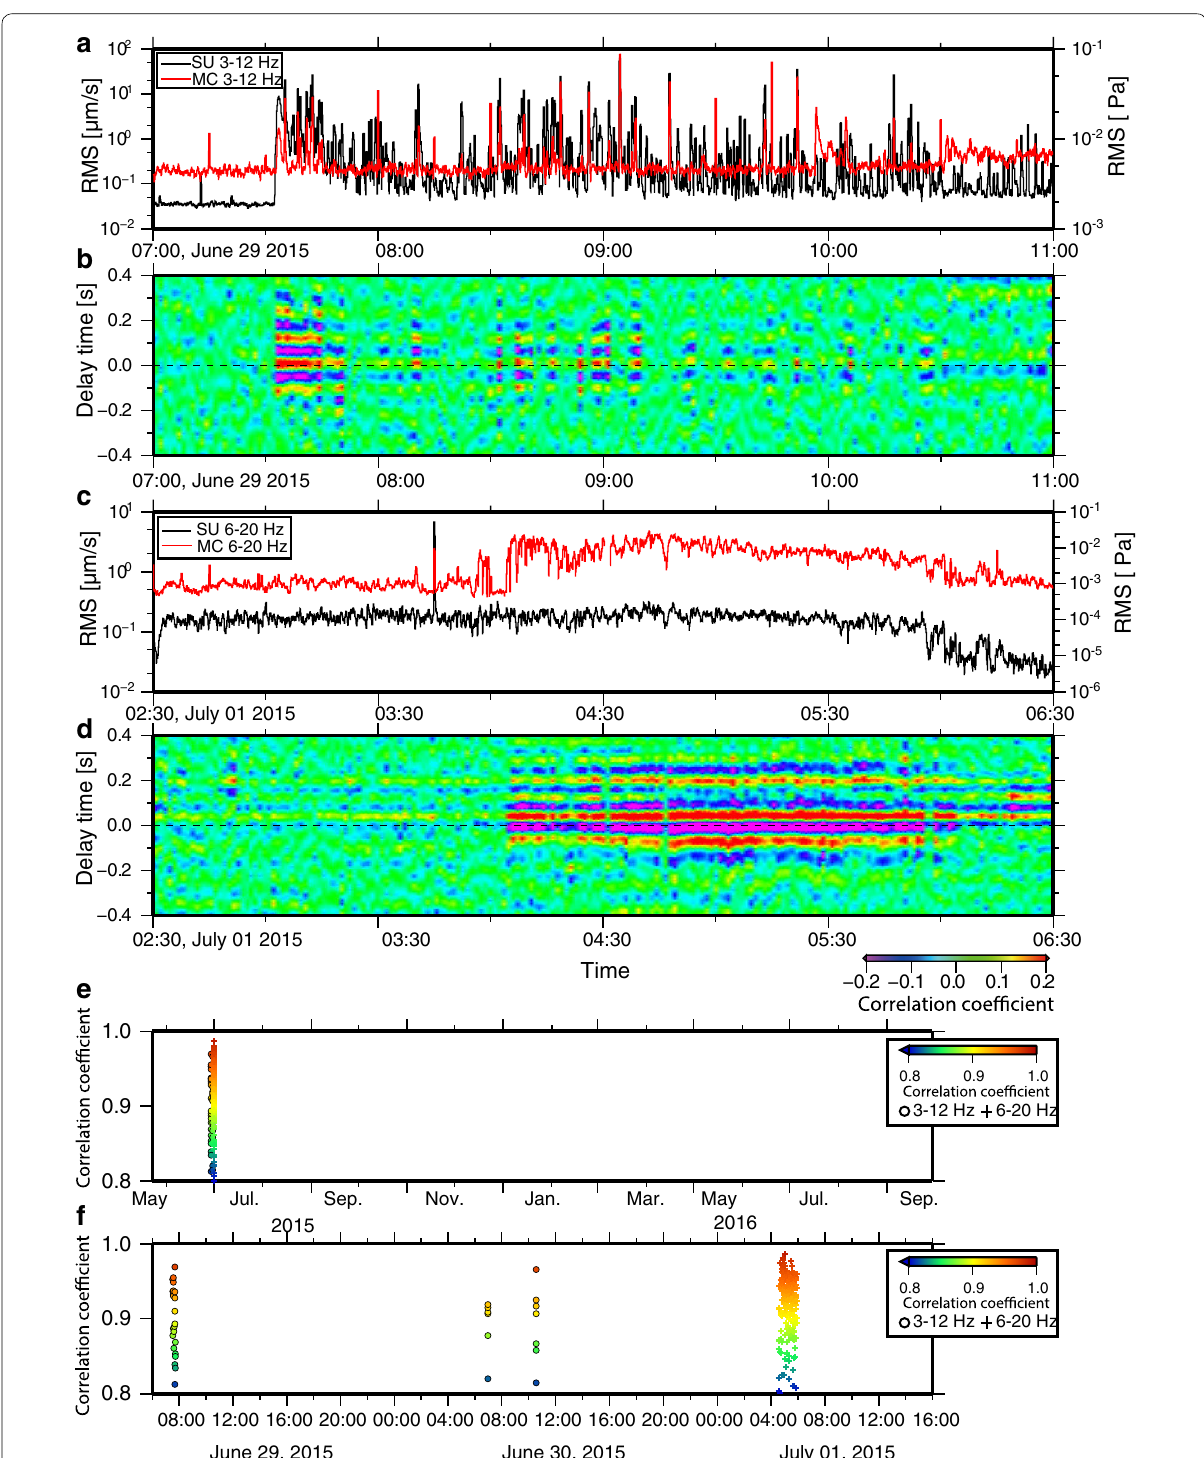
Fig. 2 Results of the cross-correlation method. a RMS amplitude over 1 min for the microphone (red line) and the vertical ground velocity (black line) at the OWD station during the period from 07:00 to 11:00 June 29, 2015 and b a temporal sequence of the microphone–seismometer correla- tion function of the band-passed seismic and infrasonic signals. c RMS amplitude during the period from 02:30 to 06:30 on July 01 and d a temporal sequence of the cross-correlation function. e Temporal sequence of the correlation coefficient between the reference and the microphone–seis- mometer correlation functions during the period from May 21, 2015, to September 30, 2016, and f its magnified plot during the